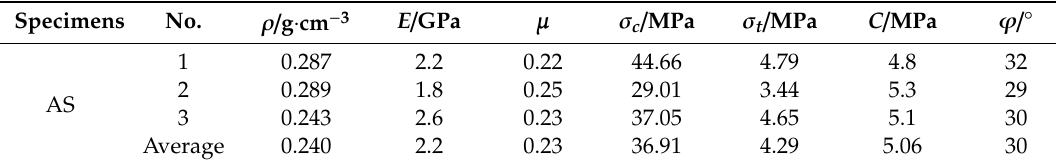
Figure 1. Some AS samples. Table 1. Physical and mechanical properties of AS.